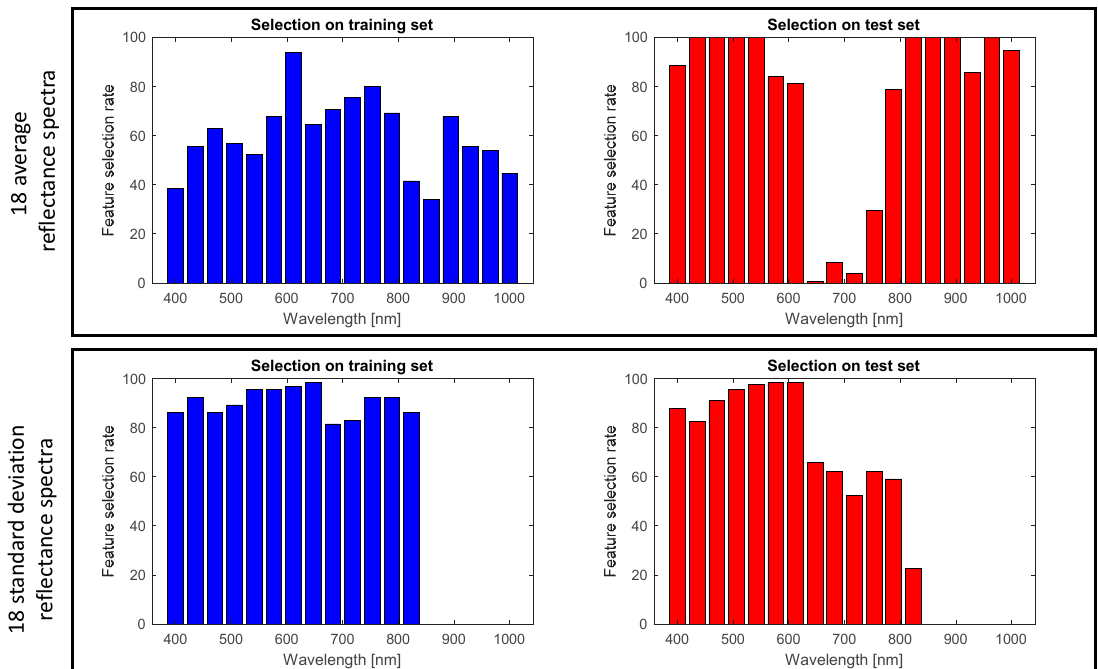
Figure 5. Histogram of the feature selection rate of the 18 average reflectance spectra ( upper ) and the 18 standard deviations of reflectance spectra ( lower ) features for the two datasets. Blue bars refer to the training sample and red bars indicate the test samples. The training results are obtained using a leave-one-out cross validation procedure.